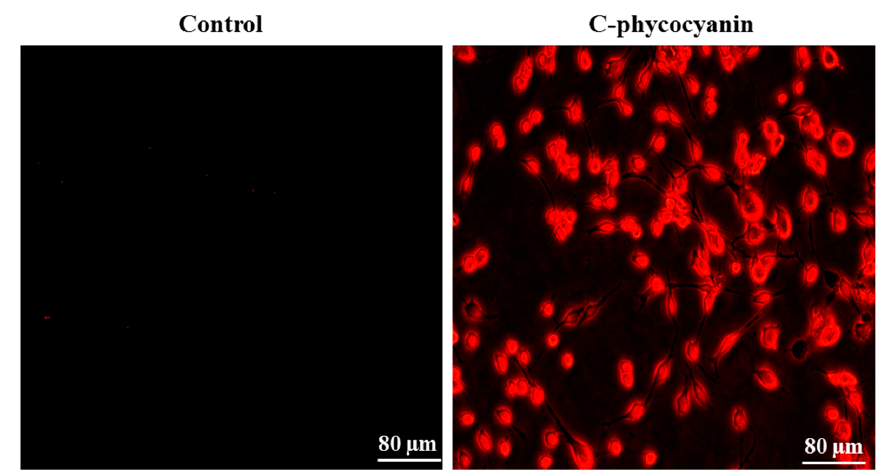
Figure 3. Fluorescence microscopic images demonstrate cellular uptake of c-phycocyanin by MBA-MD-231 using an excitation/emission range of 600/650-nm.